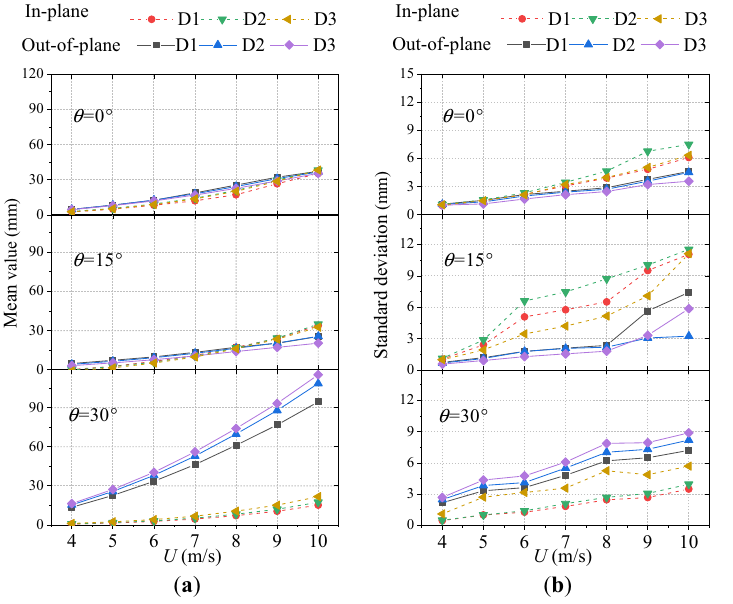
Figure 7. Mean and standard deviation values of wind-induced displacement with various wind speeds: ( a ) mean values of wind-induced displacement. ( b ) standard deviation values of wind-induced